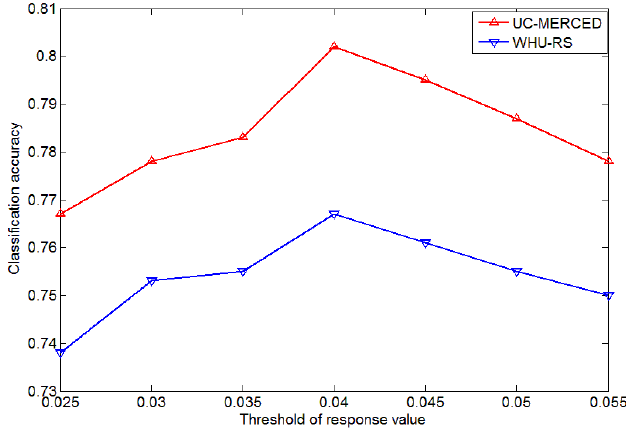
Figure 16. Classification accuracy with different thresholds of response value.